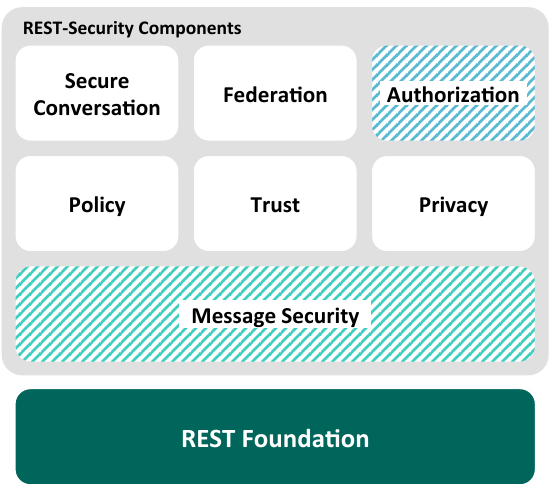
Figure 5. Desired security stack for REST-based web services